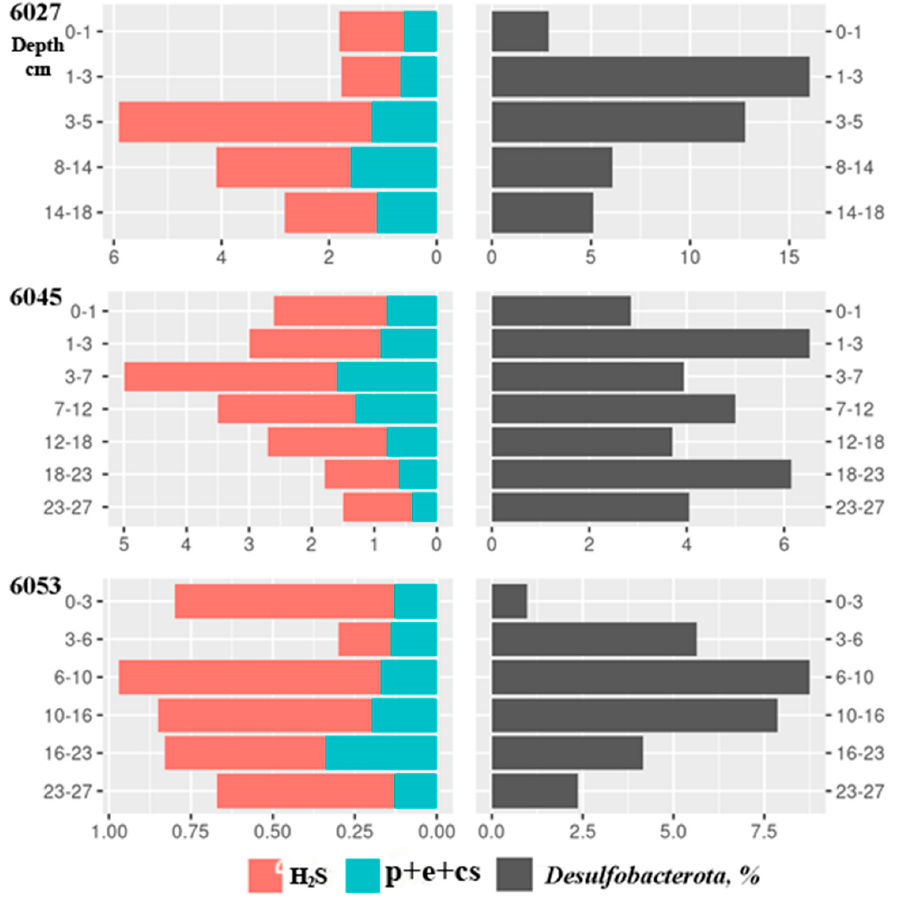
Figure 11. Sulfate reduction rates (SR, µ mol dm − 3 day − 1 ) in the Laptev Sea shelf sediments. Reduction of sulfate sulfur to sulfide (H 2 S), reduction of pyrite sulfur to S 0 , and reduction of elemental sulfur and cellular sulfur (pyrite+elemetal+crystalline sulfur).